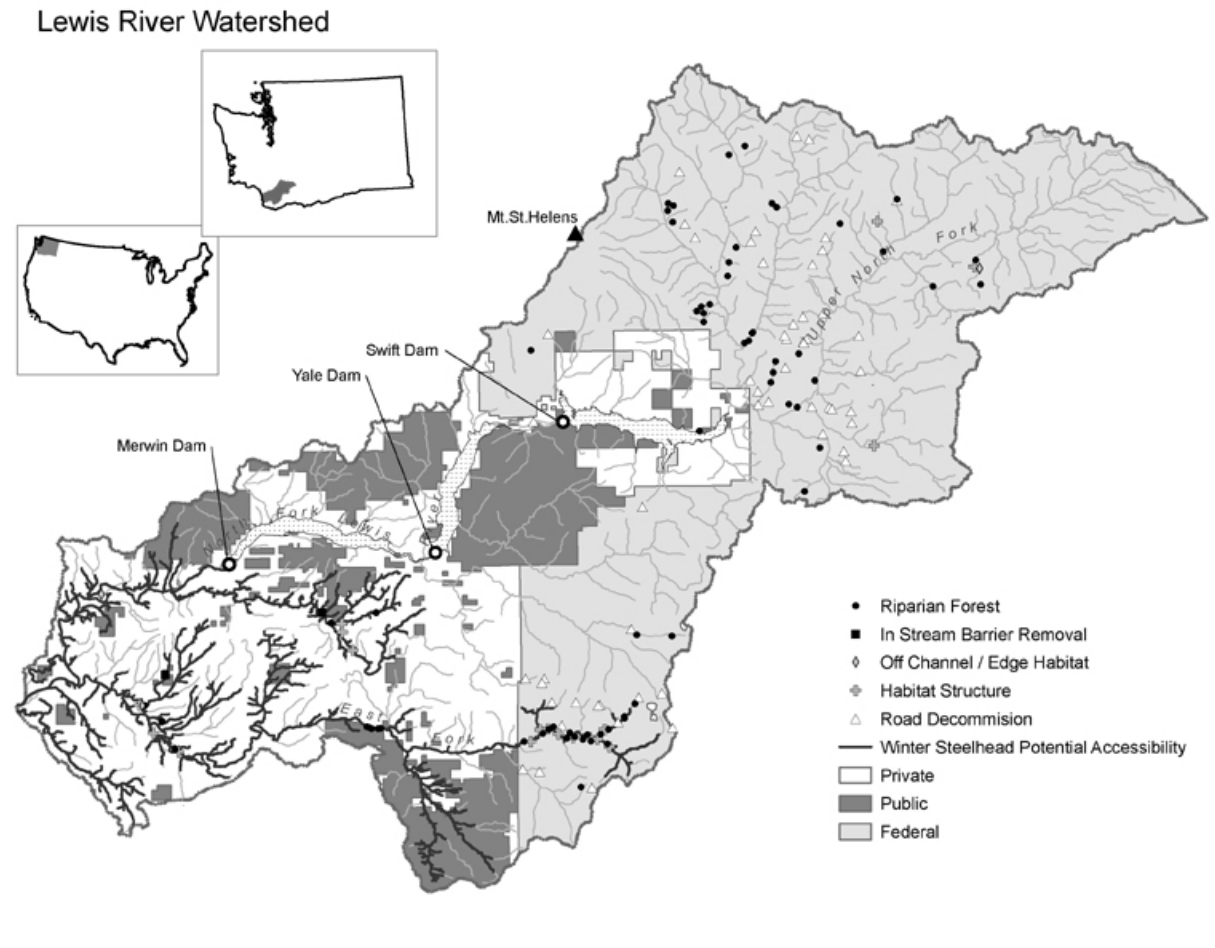
Fig. 1. The Lewis River Watershed and its location in southwest Washington State, USA. The estimated linear extent of streams and rivers accessible to winter steelhead is identified with a thick line. Key disturbance elements include three large dams, and Mt. St. Helens, an active volcano. Landownership as private, public nonfederal, and federal are denoted with shading. Restoration actions completed between 1998 and 2003 and, therefore, included as part of the modeled current conditions are identified with